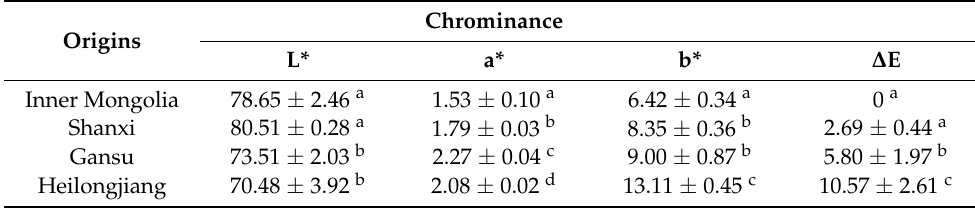
Figure 1. The appearance and yields of A. membranaceus polysaccharides from four origins (Gansu, Inner Mongolia, Shanxi, and Heilongjiang). ( A ), appearance; ( B ), polysaccharide yield; ( C ), polysac- charide content; ( D ), uronic acid content. Table 1. Chrominance of APS